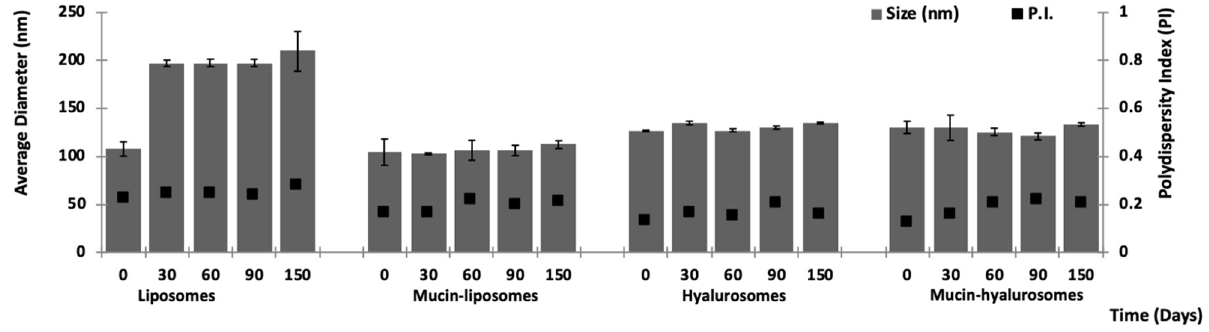
Figure 2. Average diameter and polydispersity index of vesicles stored for 5 months at room temperature (~25 °C). Mean values ± standard deviations are reported ( n = 3).